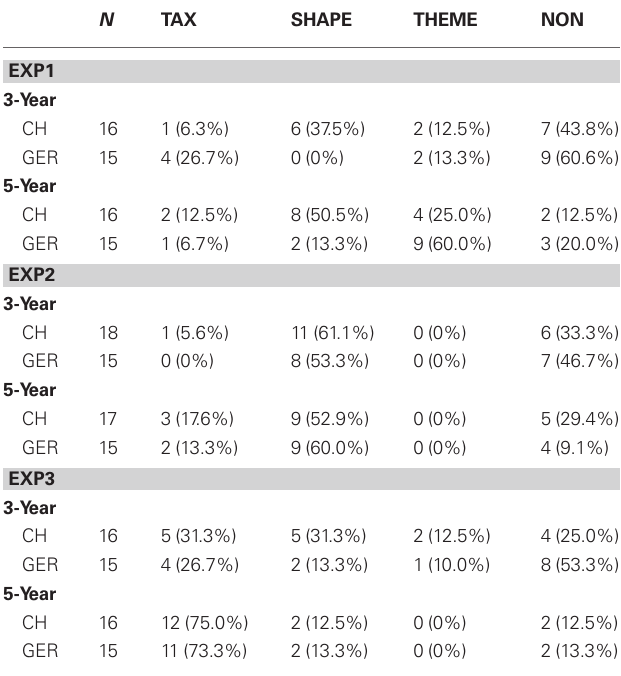
Table 3 | Frequencies of response dominance type in each task, language and